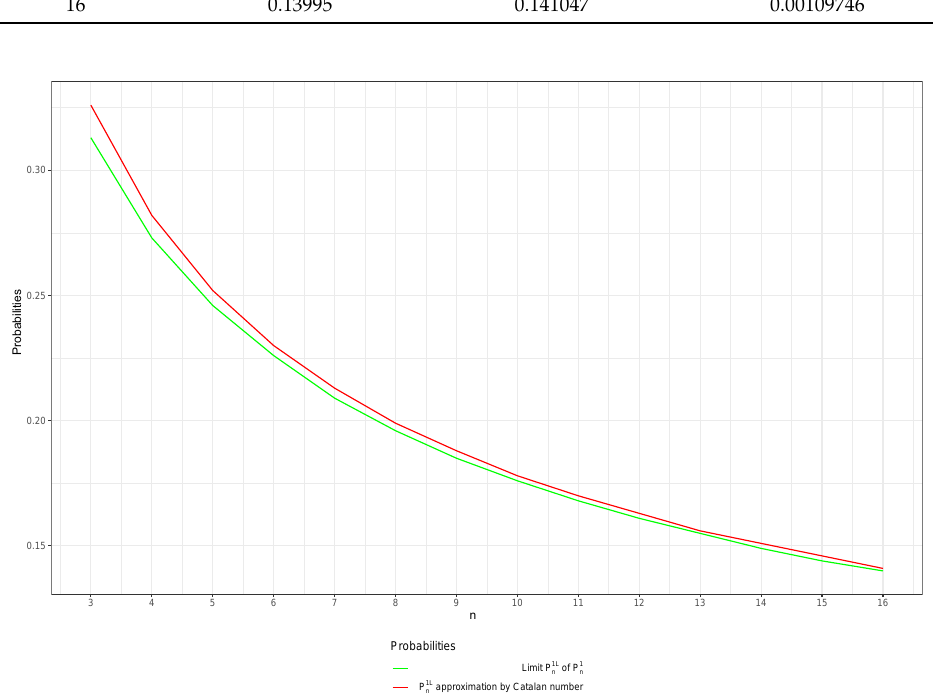
Figure 4. Curves of the two limits’ approximations obtained for P 1 n .